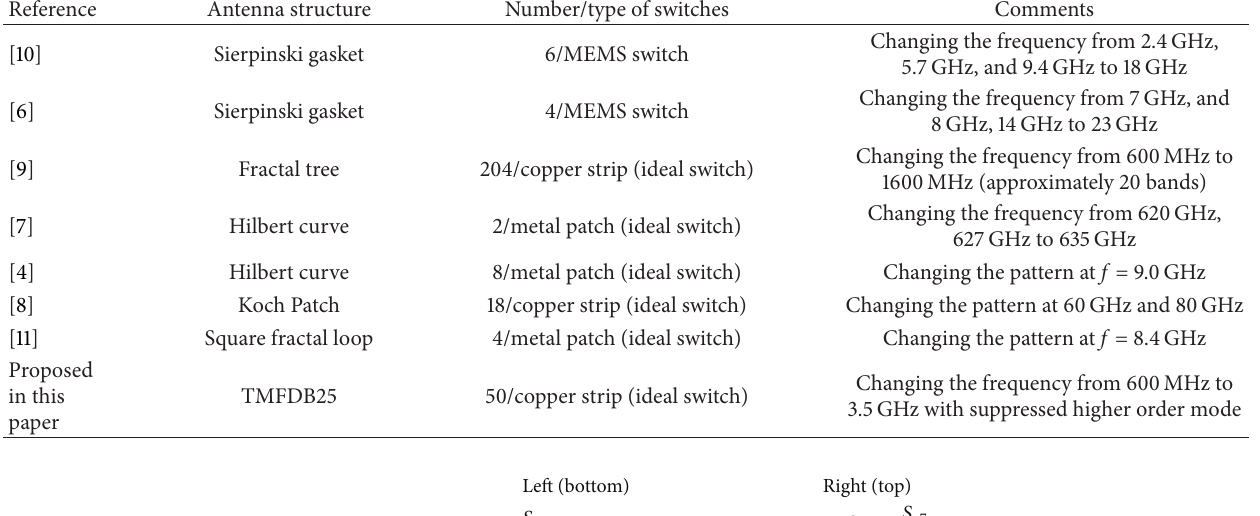
Table 2: Reconfigurable fractal antenna.